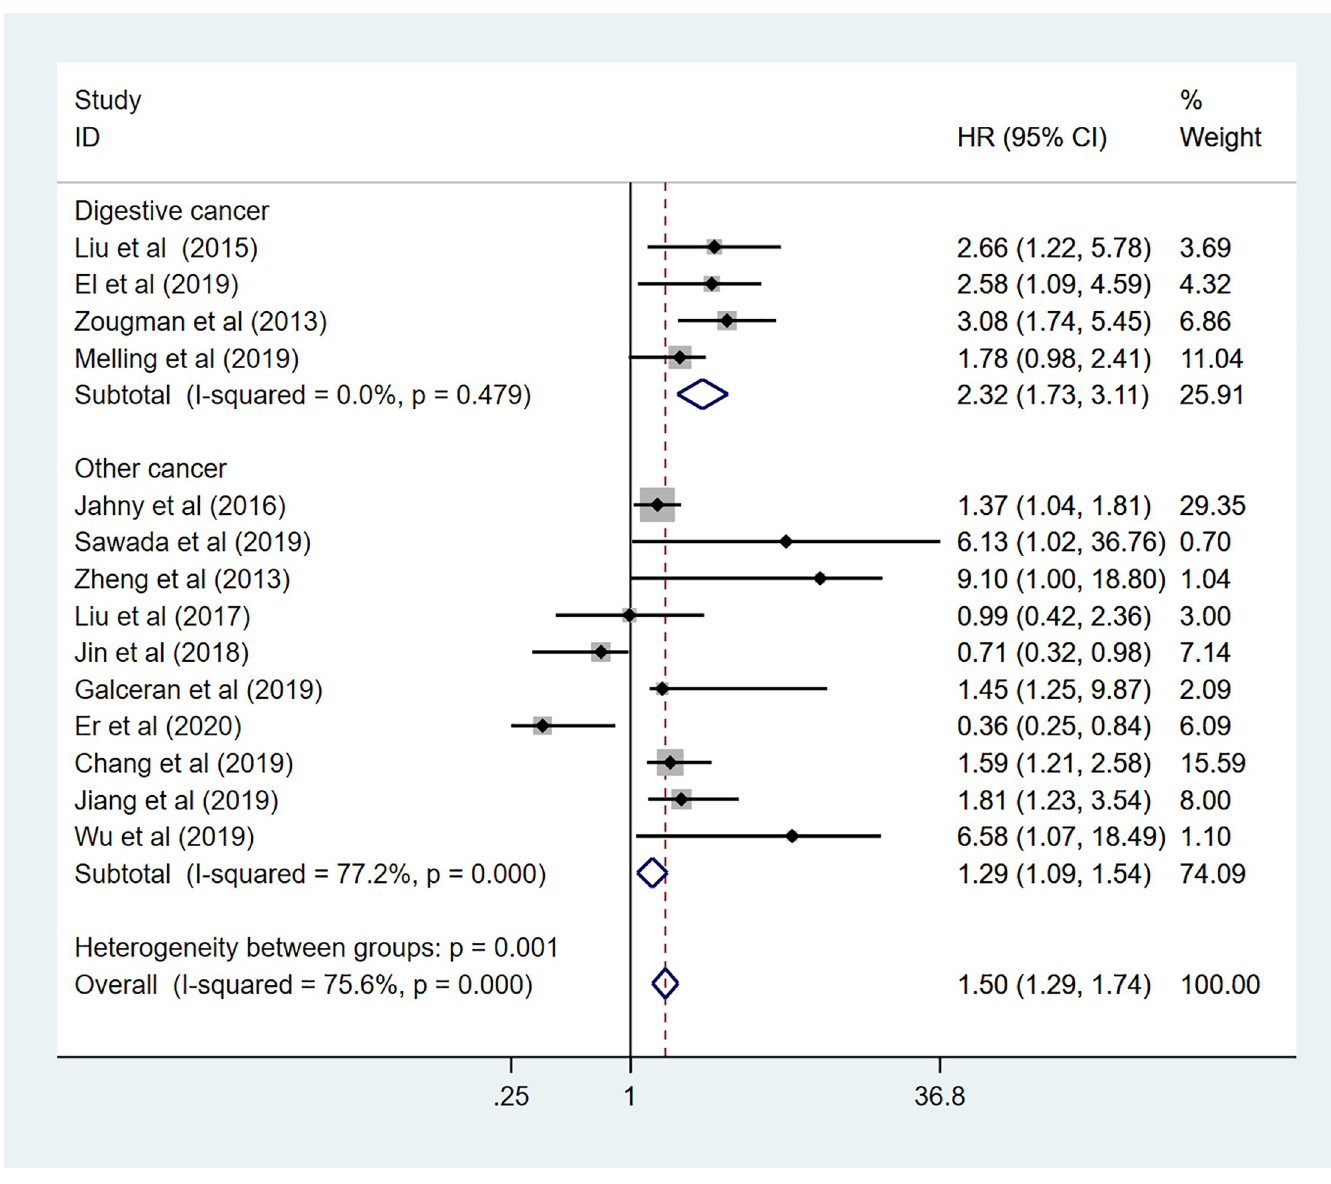
of GPRC5A inhibited colitis-associated tumorigenesis [39]. In gastric cancer, GPRC5A